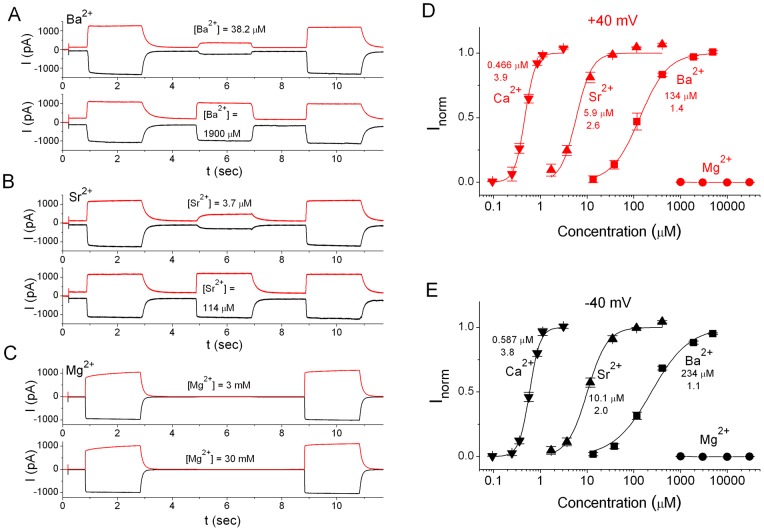
Comparison of the sensitivities of ANO1 activation by different divalent cations.(A, B & C). Original recording traces showing the activation of ANO1 by various concentrations of divalent cations at −40 mV (black) and +40 mV (red). The saturated currents before and after the experimental concentrations of divalent cations were induced by 20 µM free Ca2+. (D & E) Dose-dependent activations of ANO1 by various divalent cations. Solid curves were the best fit of data points to eq. 1, with values of K1/2′s (in µM) and Hill coefficients shown. The calcium-activation curves are the same as those shown in Fig. 2 B. N = 4 and 5 for the Sr2+ and the Ba2+ experiments, respectively. Data points with Mg2+ (N = 4) are connected by straight line segments. Membrane voltages are indicated on top of each panel.